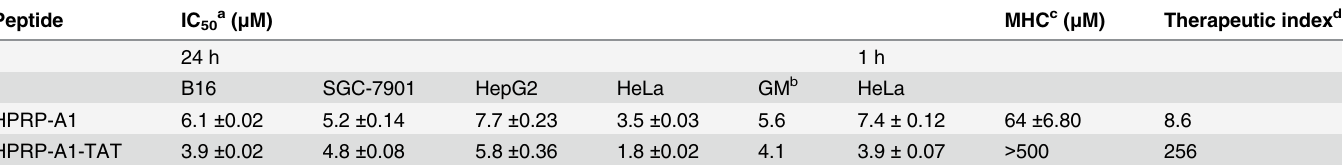
a Anticancer activity (IC 50 ) represents the concentration of peptides at which cell viability was inhibited by 50% in comparison with the untreated cells. The MTT assay was repeated in triplicate, and IC 50 value was determined by averaging three repeated experiments. b GM of the anticancer activity (IC 50 ) for the four cancer cell lines. c Hemolytic activity (MHC) was determined using human red blood cells after incubation with peptides for 1 h. If no hemolytic activity was observed at 500 μ M, a value of 1000 μ M was used for calculating the therapeutic index. fi city. d Therapeutic index = MHC/IC 50 . Larger values indicate greater anticancer speci GM, geometric mean; MHC, minimal hemolytic